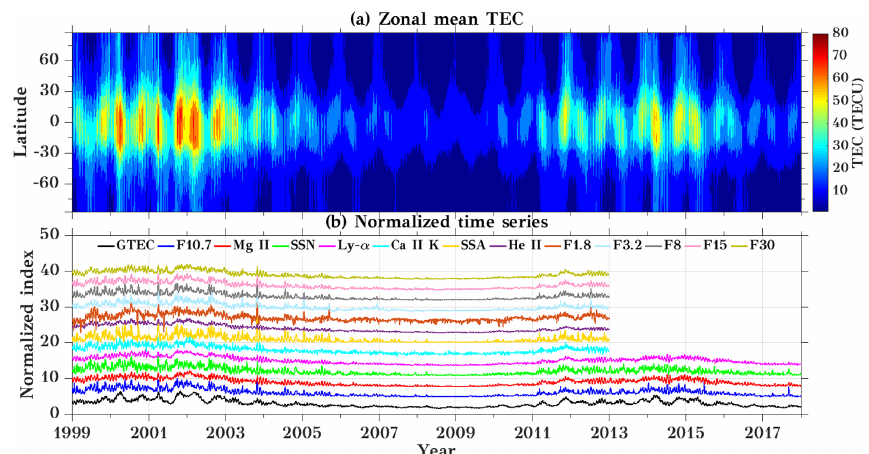
Figure 1. Time series of (a) zonal mean TEC and (b) smoothed normalized datasets of GTEC and different solar proxies for the years 1999 to 2017. The curves in (b) are vertically offset by 3 each. x axis labels refer to 1 January of the respective year.